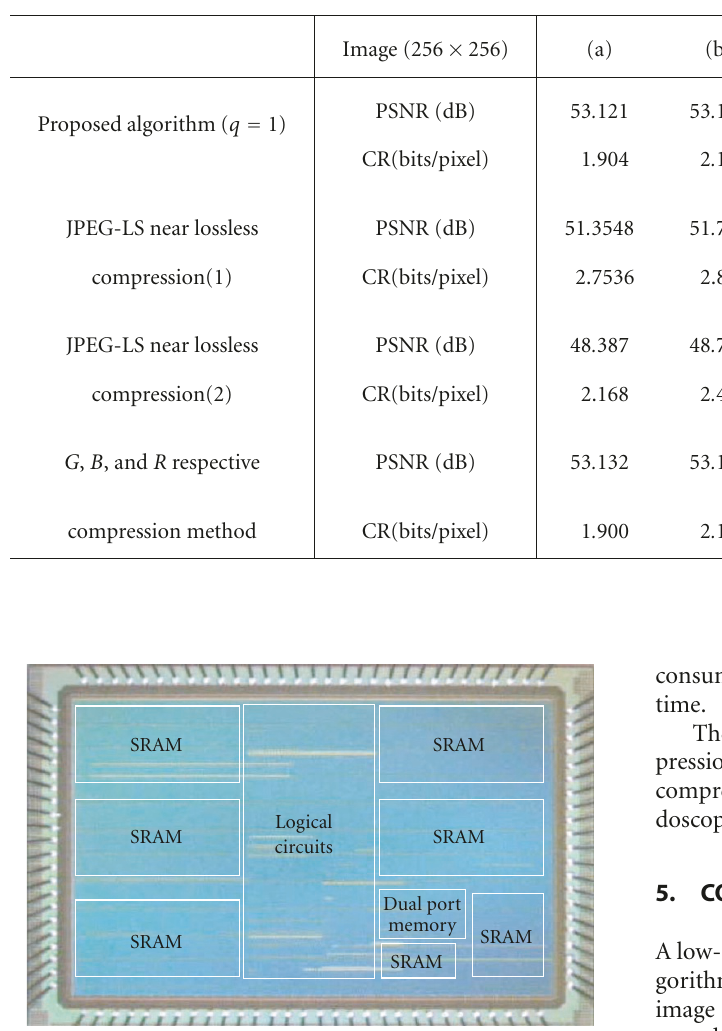
Table 4: Compression results for the six digestive tract images. CR means compression rate